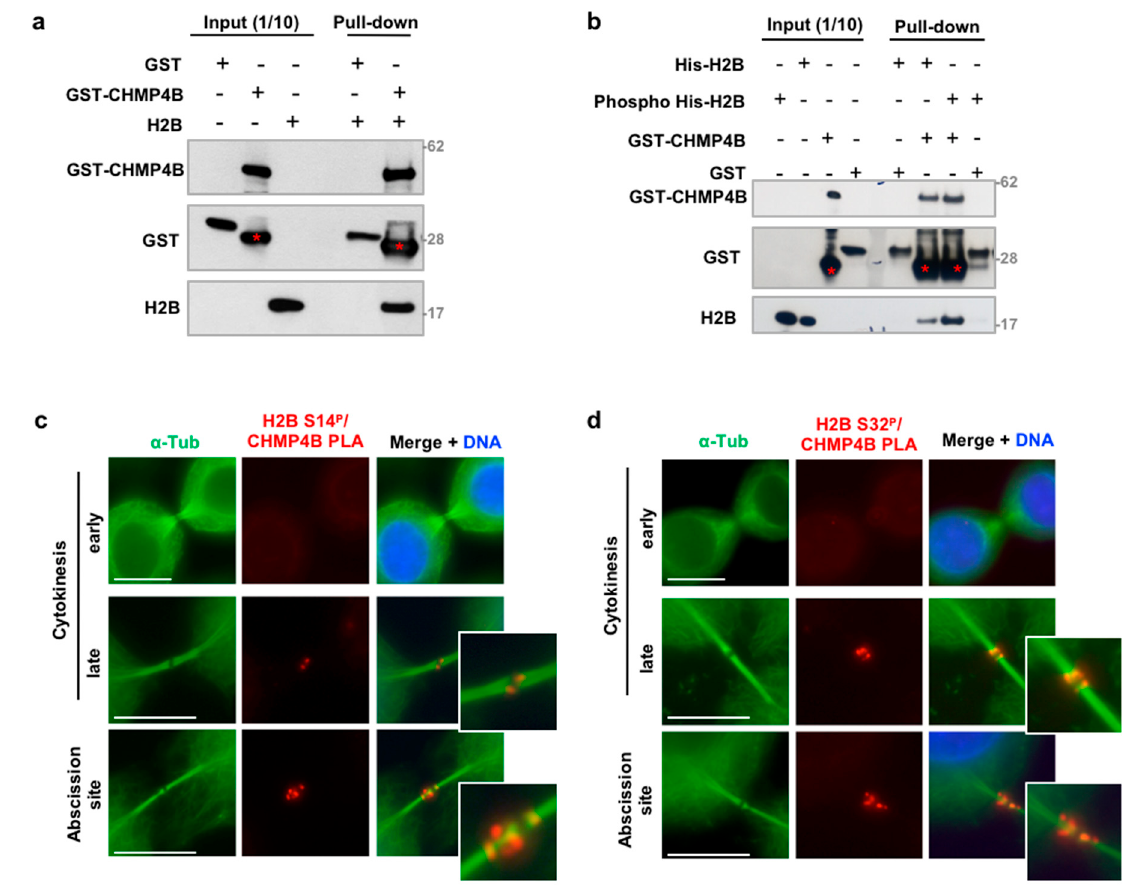
Figure 5. ecH2B binds and colocalizes with CHMP4B at the intercellular bridge. ( a ) GST-pull down was performed to analyze the binding between recombinant GST-CHMP4B and H2B. GST alone was used as negative control. WBs were performed to detect the indicated proteins. Red asterisks (*) indicate GST-CHMP4B sub-products consistently present in the commercial preparation. ( b ) Recombinant His-H2B was phosphorylated at Ser14 by incubation with HIPK2 Kinase Domain (HIPK2 KD) in the presence of cold γ -ATP. GST-pull down was performed to compare the binding between recombinant GST-CHMP4B and His-H2B or His-H2B-S14 P . GST alone was used as negative control. WBs were performed to detect the indicated proteins. Red asterisks (*) indicate GST-CHMP4B sub-products. ( c,d ) Proliferating, asynchronous HeLa cells were fixed and analyzed by proximity ligation assay (PLA) with anti-CHMP4B Ab and anti-phospho-H2B-Ser14 in two independent experiments ( c ) or anti-phospho-H2B-Ser32 Abs in two other independent experiments ( d ). Representative images of cells in early and late cytokinesis and abscission sites are shown. 30 ICBs per sample were analyzed and overall PLA positivity was observed in 37.7 ± 2.5% of the ICBs. Scale bar is 10 µ